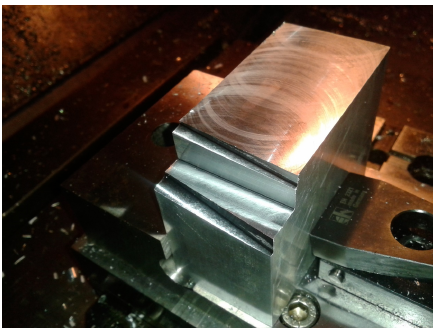
Figure 7. Workpiece after the measurements; on the lower side the variable axial-radial depth test can be seen.